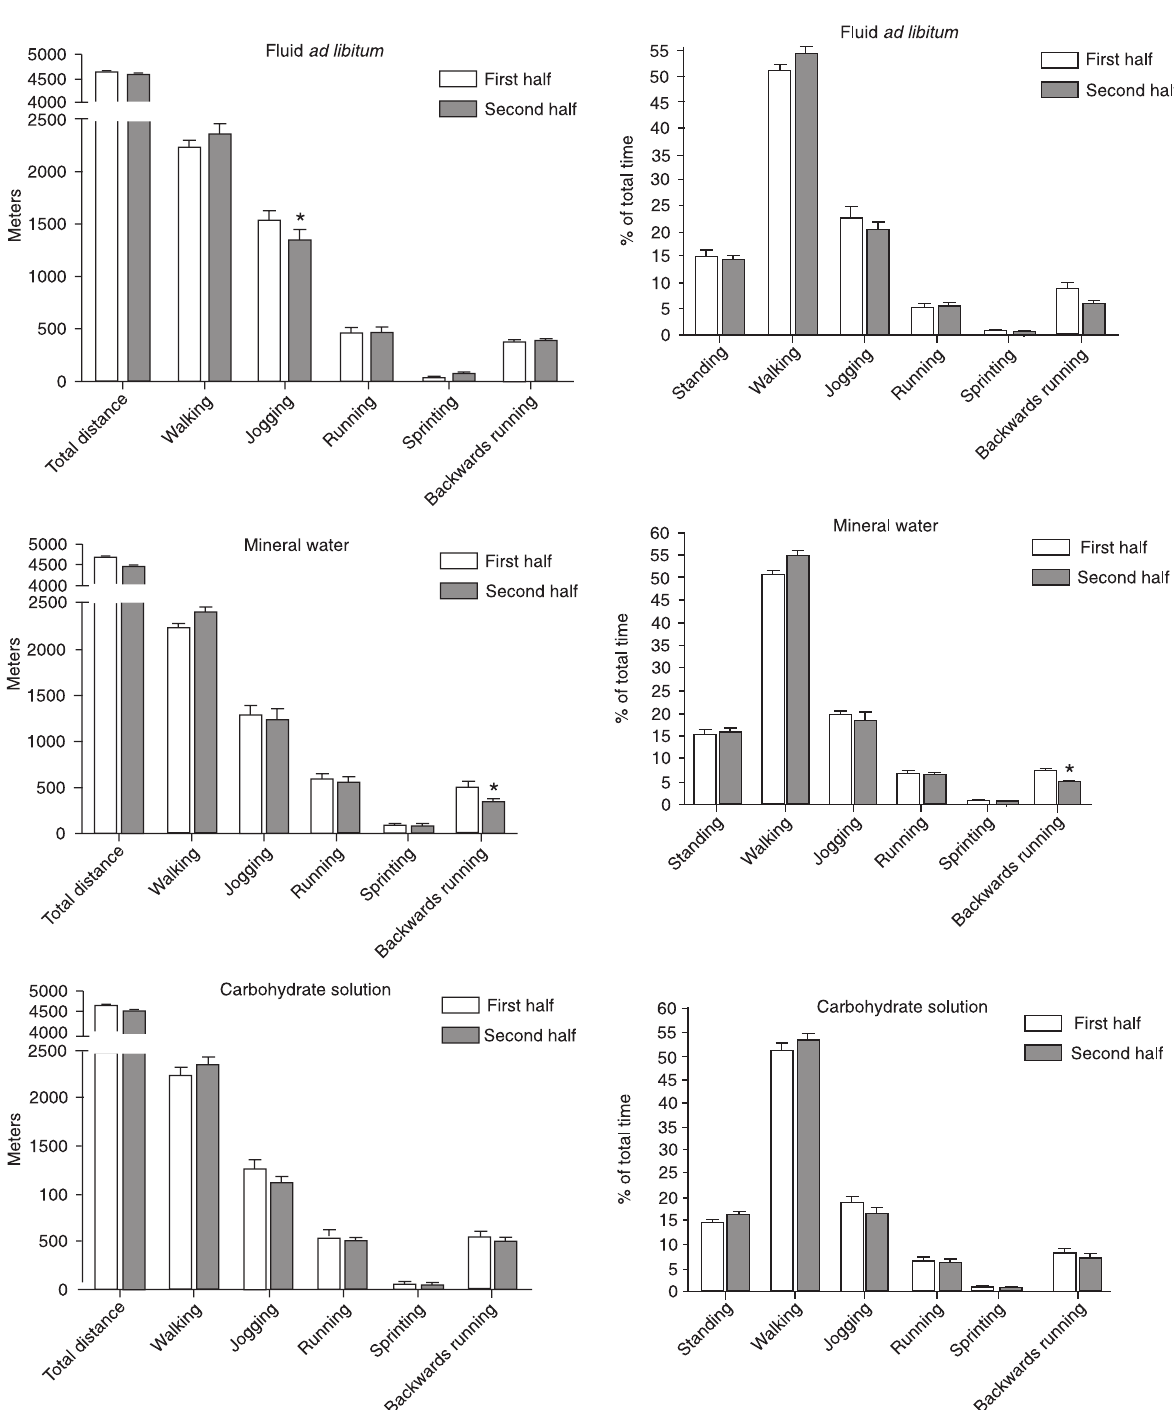
Figure 2. Activities performed by football referees in different lo- comotive categories during the first half (open bars) and second half (filled bars) of a match reported as percentage of total time (means ± SEM). *P < 0.05 for the difference between the first and second halves (two-tailed Student